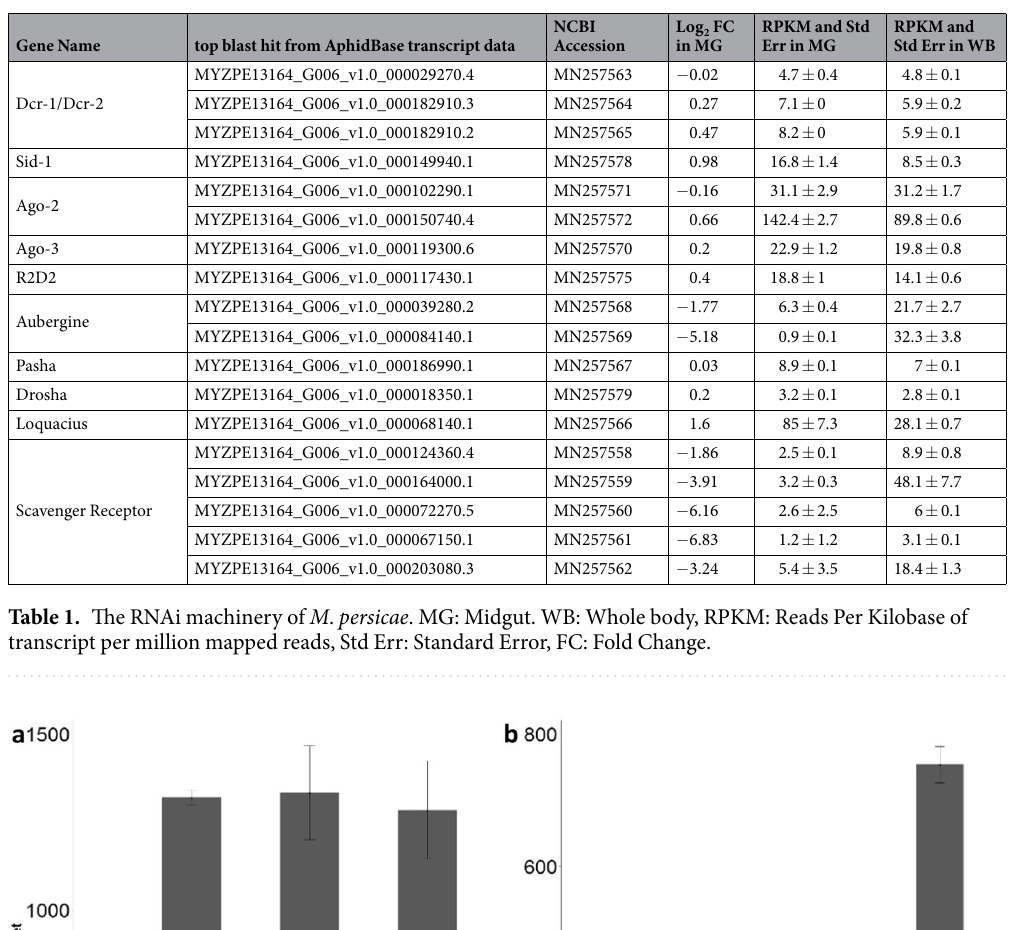
samples were vortexed briefly and incubated at room temperature. Analysis of dsRNA concentration after 15, 30 and 60 minutes of incubations showed that the dsRNA was rapidly degraded (Fig. 5b). To characterize the speed of this degradation we repeated these experiments and found that most of the dsRNA was degraded within 5 min- utes (Supplementary Fig. 8). We also found that the dsRNA degradation was inhibited by neutral saline citrate buffer (Supplementary Fig. 8) – a known nuclease inhibitor 34 .